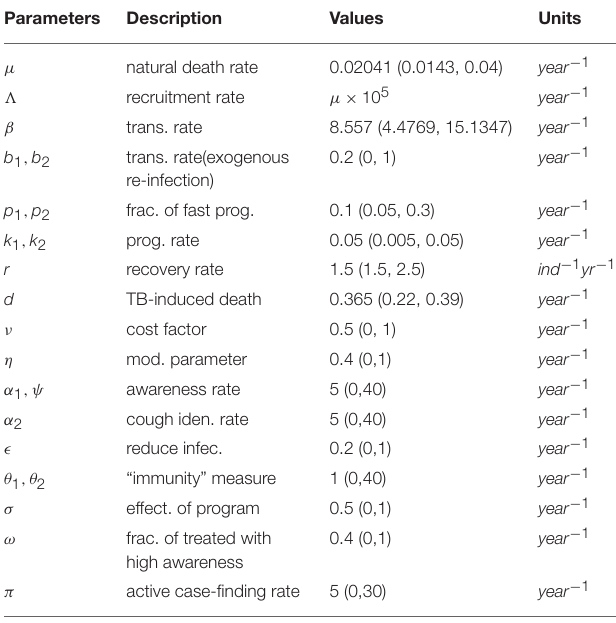
TABLE 1 | Parameter